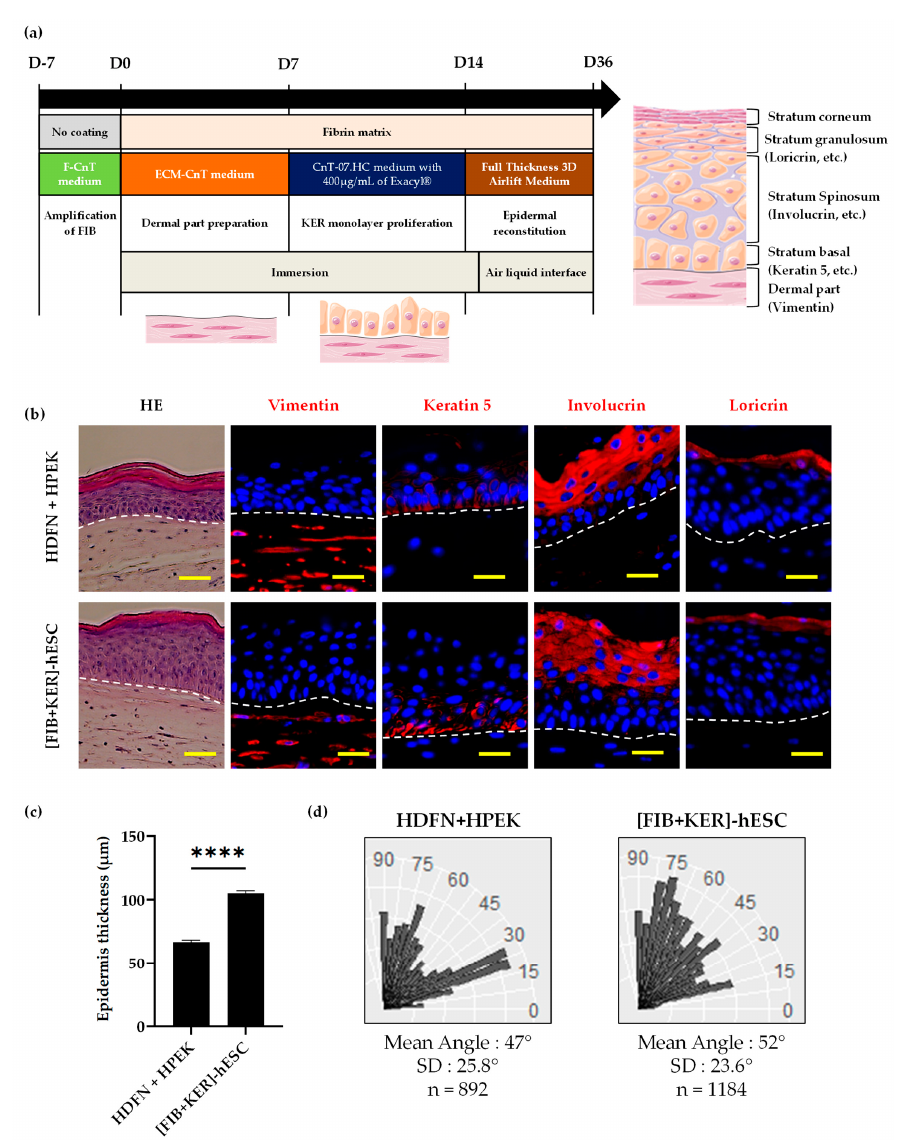
Figure 3. Functional characterization of composite skin substitute derived from hESC. ( a ) Schematic representation of the clinical production of dermo epidermal reconstituted tissues. Illustrated using